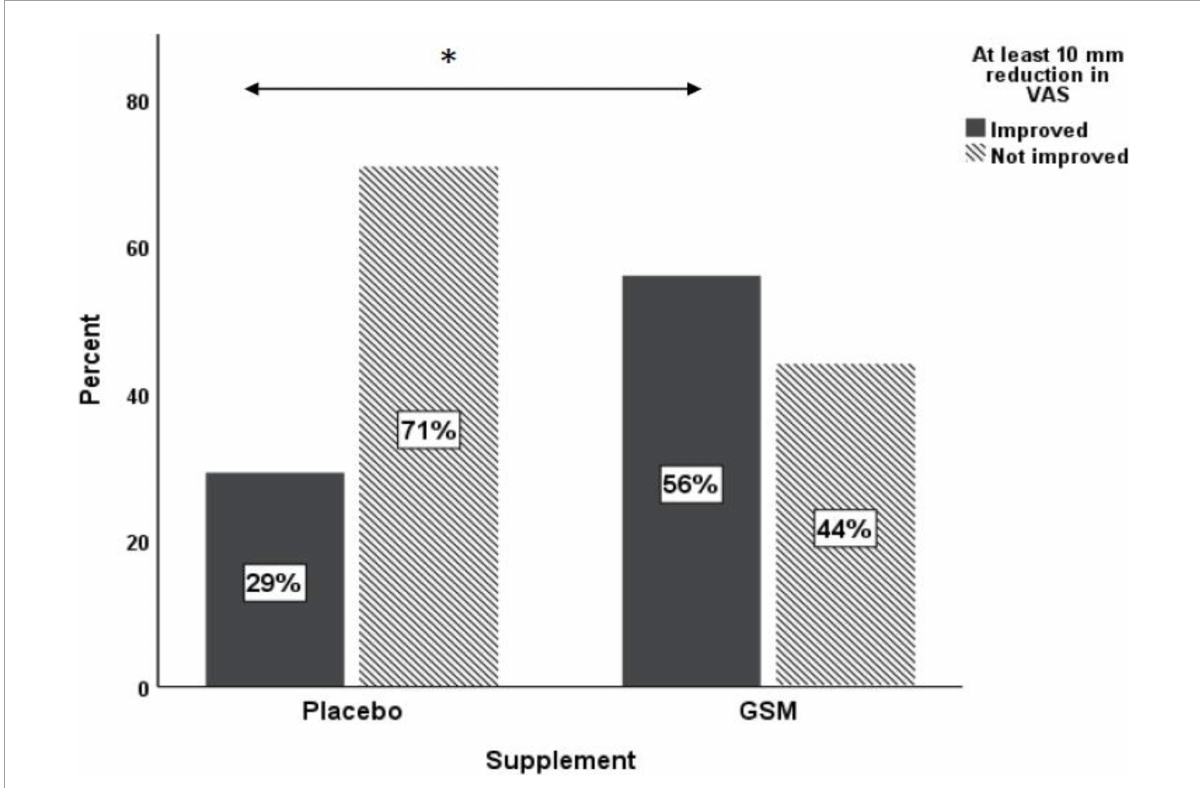
FIGURE5 Proportion of responders [those who had ≥ 10 mm reduction in baseline visual analogue scale (VAS)] versus non-responders in placebo and GSM supplement groups. ∗ Pearson’s chi-square test P =